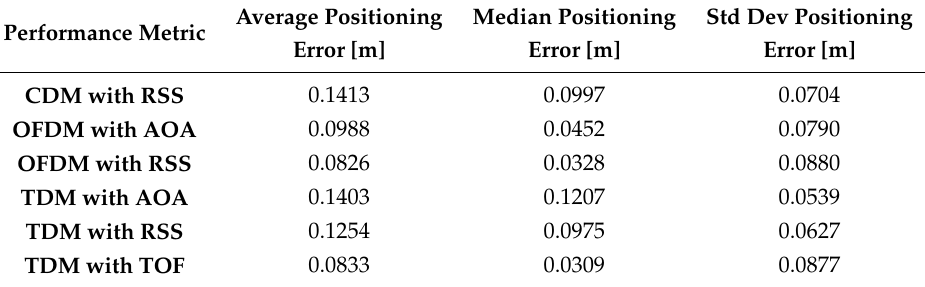
Table 8. Two Phase: Coarse/Fine Positioning Average, Median, and Standard Deviation of Positioning